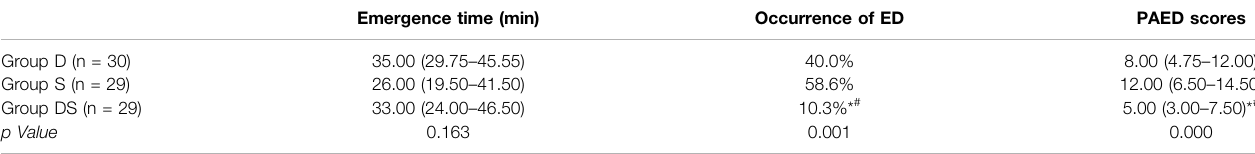
TABLE 6 | Emergence time and emergence quality. Emergence time (min) Occurrence of ED